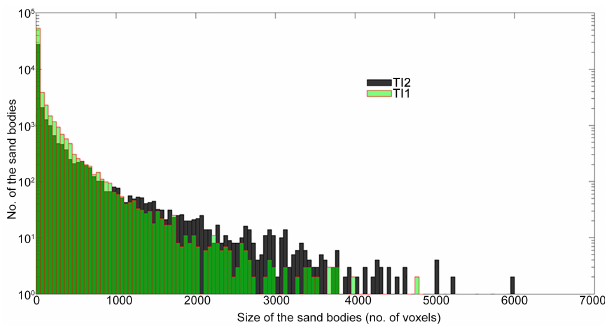
Figure 14. Probability of the jaggedness of the sand bodies (with a size larger than 1000) for the unconditioned realizations obtained by using the TI1 and TI2 in Fig.